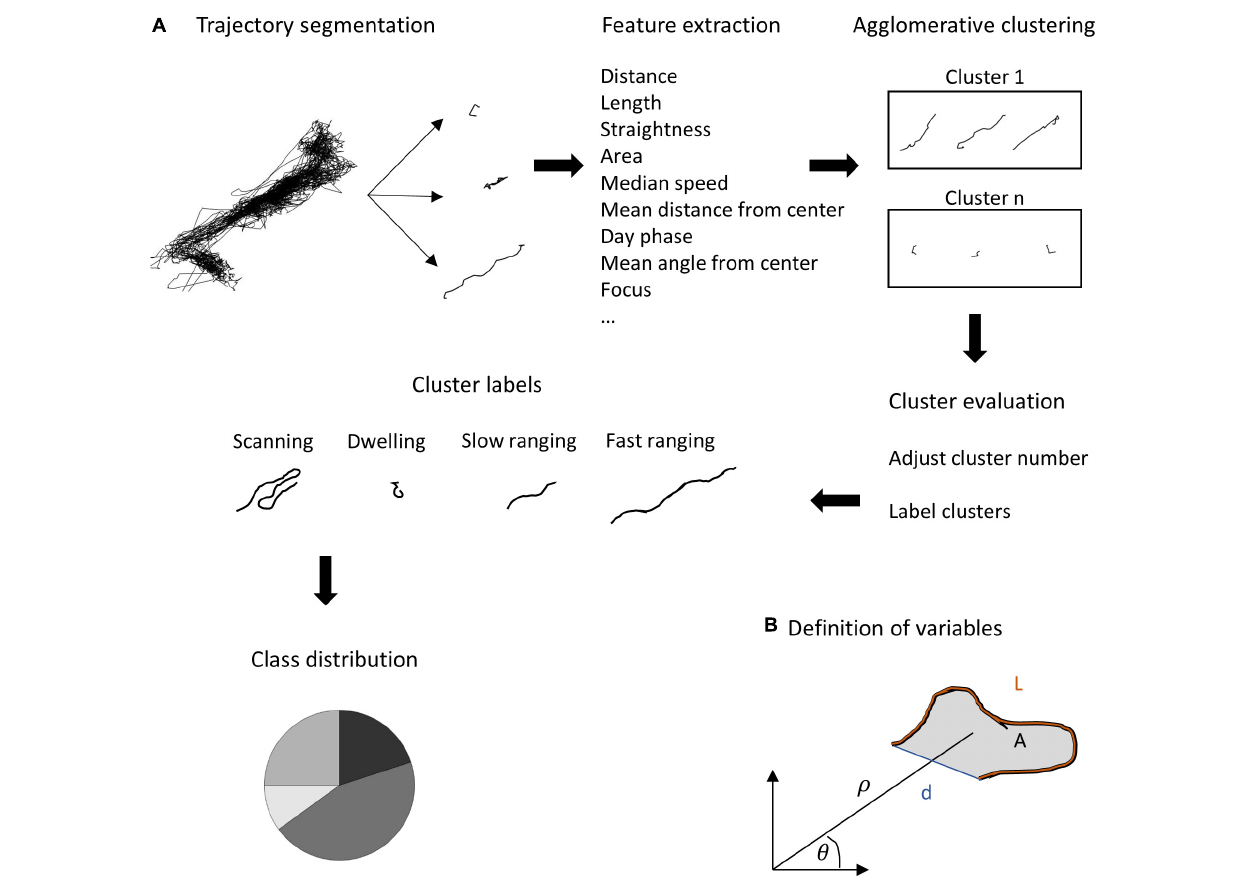
FIGURE 4 | Feature calculations and semi-supervised clustering algorithm. (A) The daily trajectory was segmented into overlapping segments. For each segment, a set of features was calculated (see Table 1 for formal definitions). Agglomerative clustering was applied to the data to obtain a set of classes of trajectory segments. Finally, a manual correction for similar classes was applied to avoid over- splitting of the classes. (B) Definition of the fundamental features used for clustering: the path length of the segment (L), the total area of the segment which was defined as the polygon covering the set of points of the segment, the distance from the segment’s start and end, (d) The distance and direction of the center of mass of all points defining the segment from the center of the trajectory ( ρ and θ ,